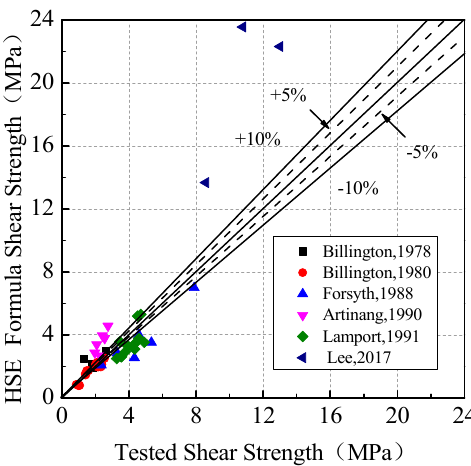
Figure 14. Comparison of shear strength calculated using HSE and tested results.